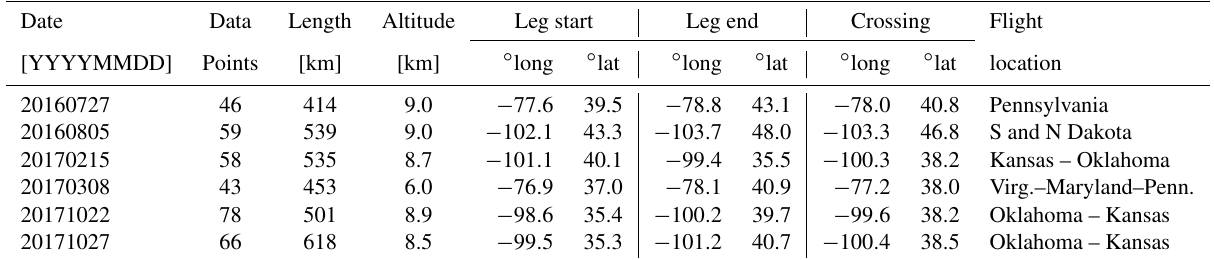
Table 1. Information on which MFLL–OCO-2 co-location points from which ACT-America flight legs were used in this study, including the crossing locations (points of closest approach between the aircraft and OCO-2 FOVs). See Bell (2018) and Bell et al. (2020) for more